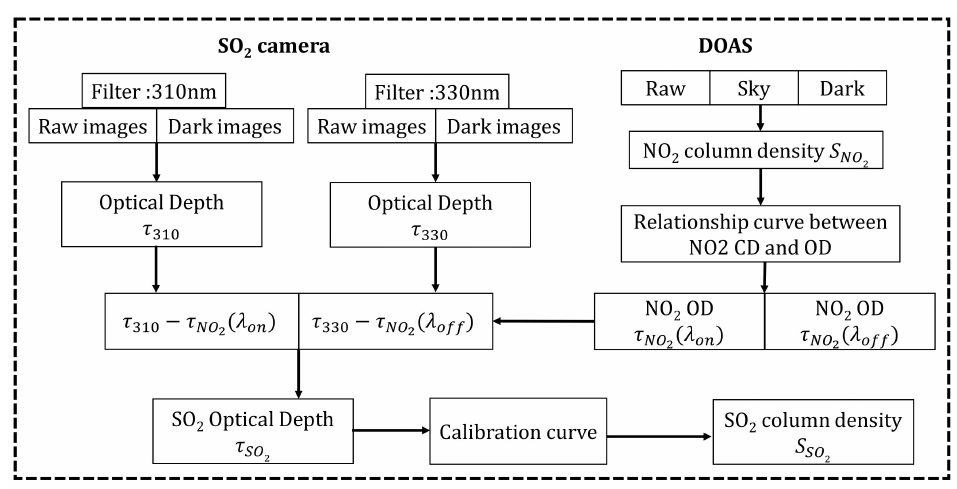
Figure 6. Flow chart of data